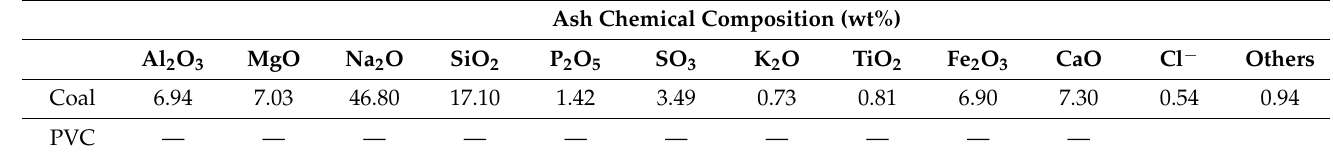
Table 2. Chemical composition of the coal and PVC ash.